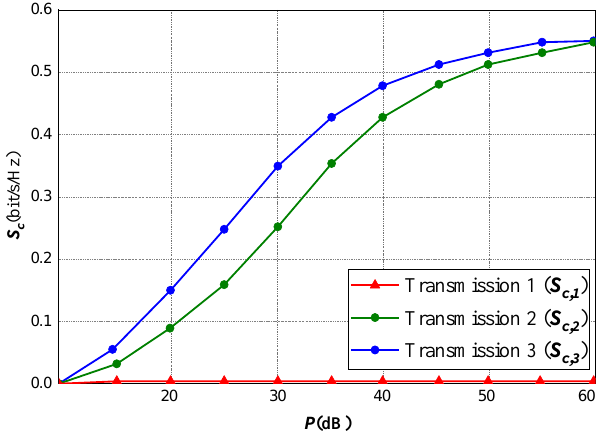
Figure 3. Realized privacy capacity against eavesdroppers under power and rate constraints.